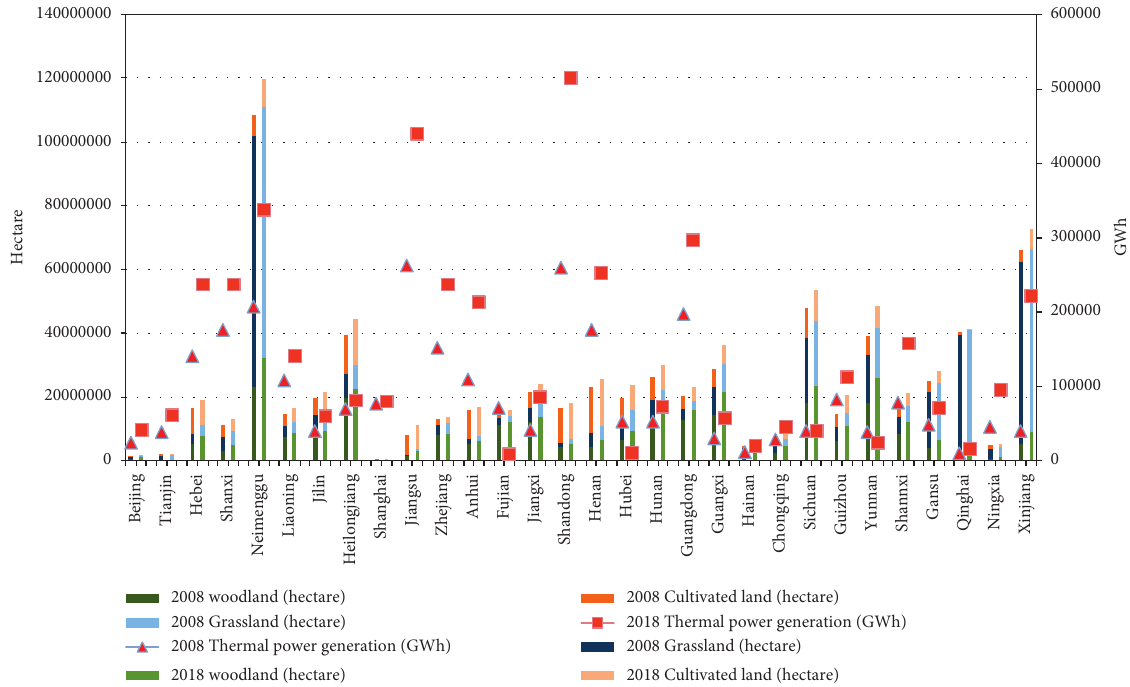
Figure 5: Thermal power generation and bioproductive land areas in China’s provinces in 2008 and